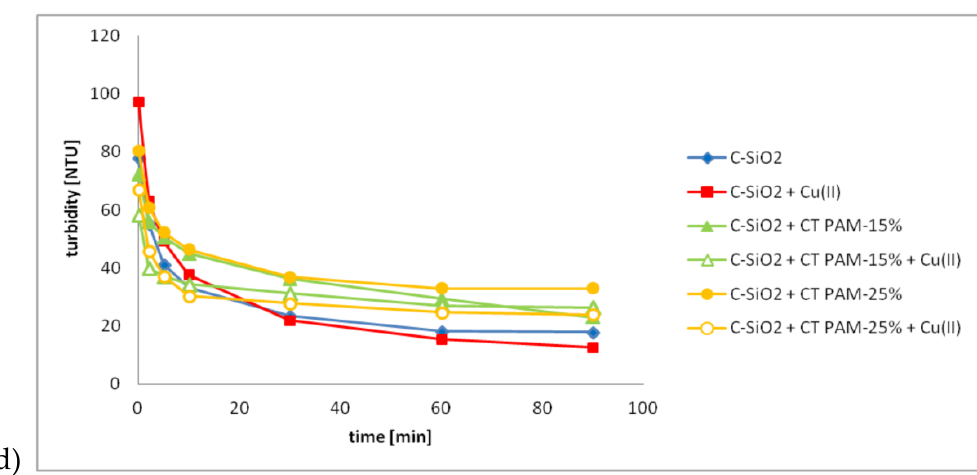
Figure 6. Turbidity changes of the C-SiO 2 suspension without and with ionic polyacrylamide and/or Cu(II) ions over time at pH 6; the PAM concentration was 50 ppm ( a , b ) or 100 ppm ( c , d ), whereas the Cu(II) one—100 ppm.